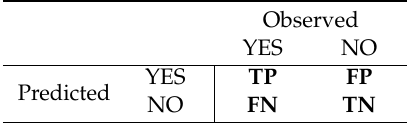
Table 1. Confusion matrix (a type of contingency